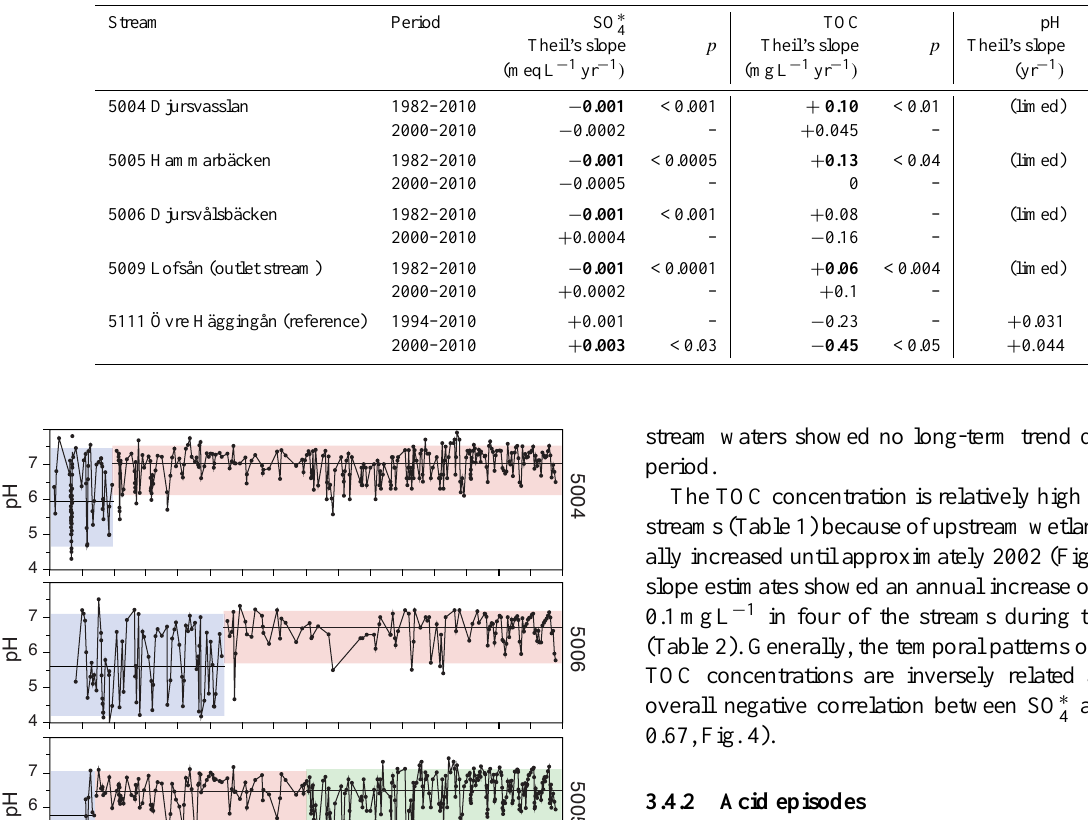
), total organic carbon (TOC) and pH in the streams during 4